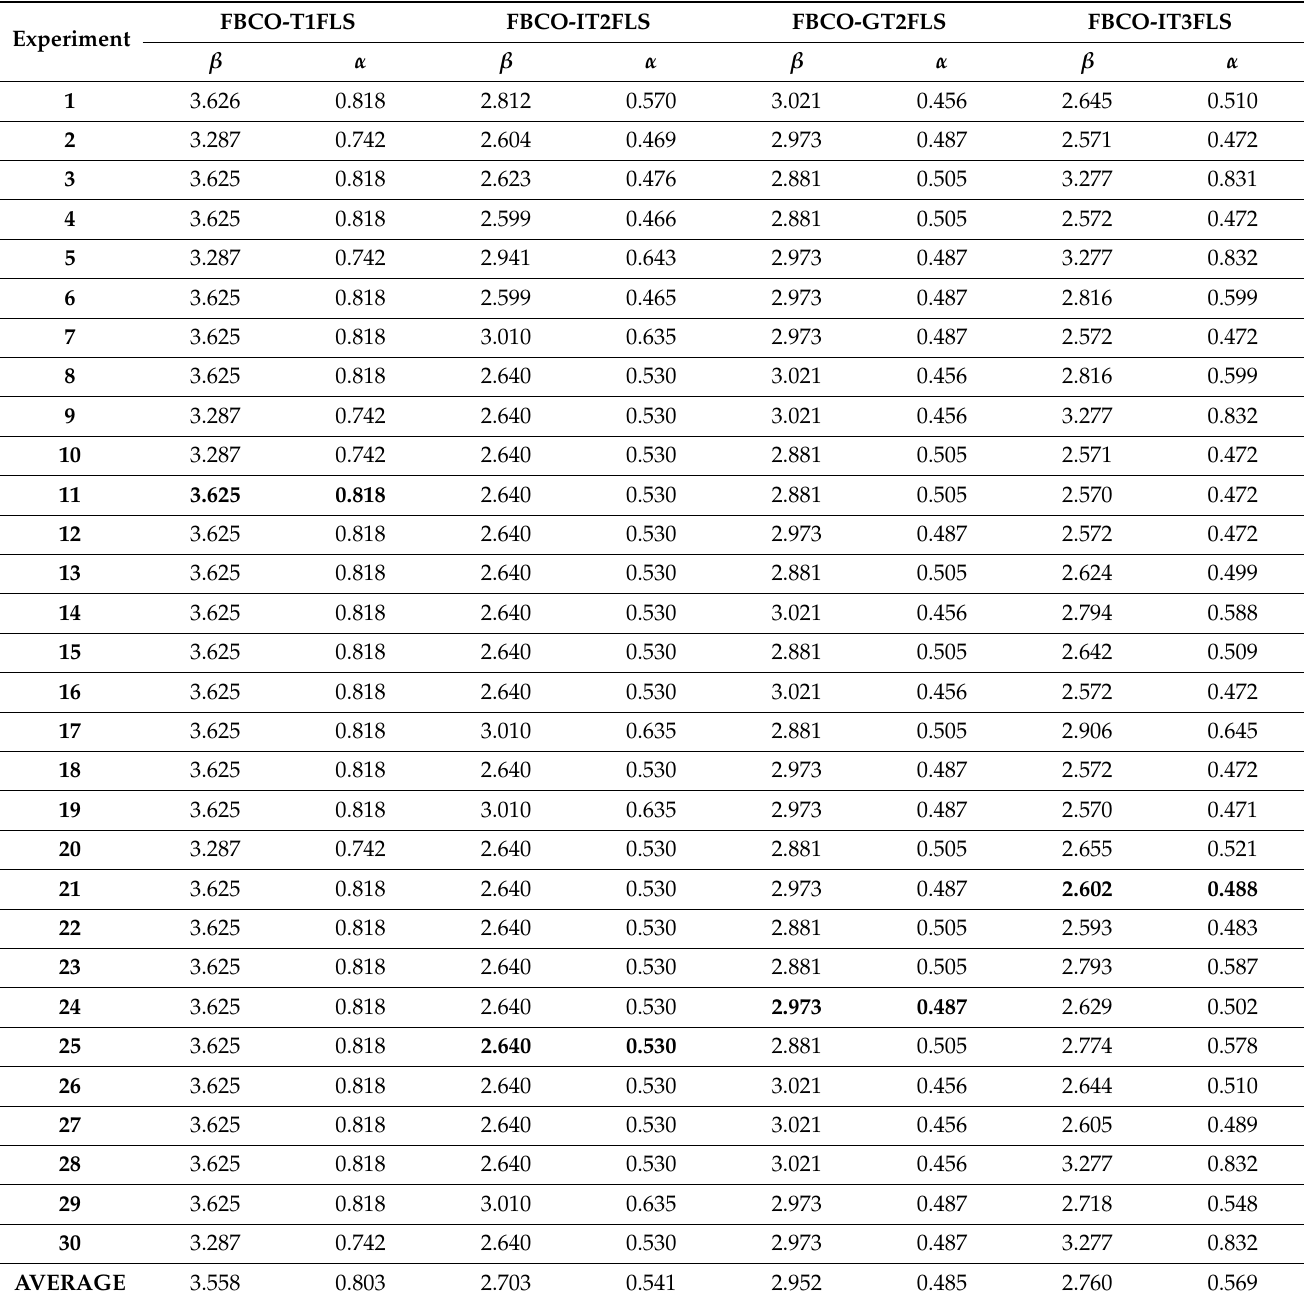
Table 3. Results of the α and β